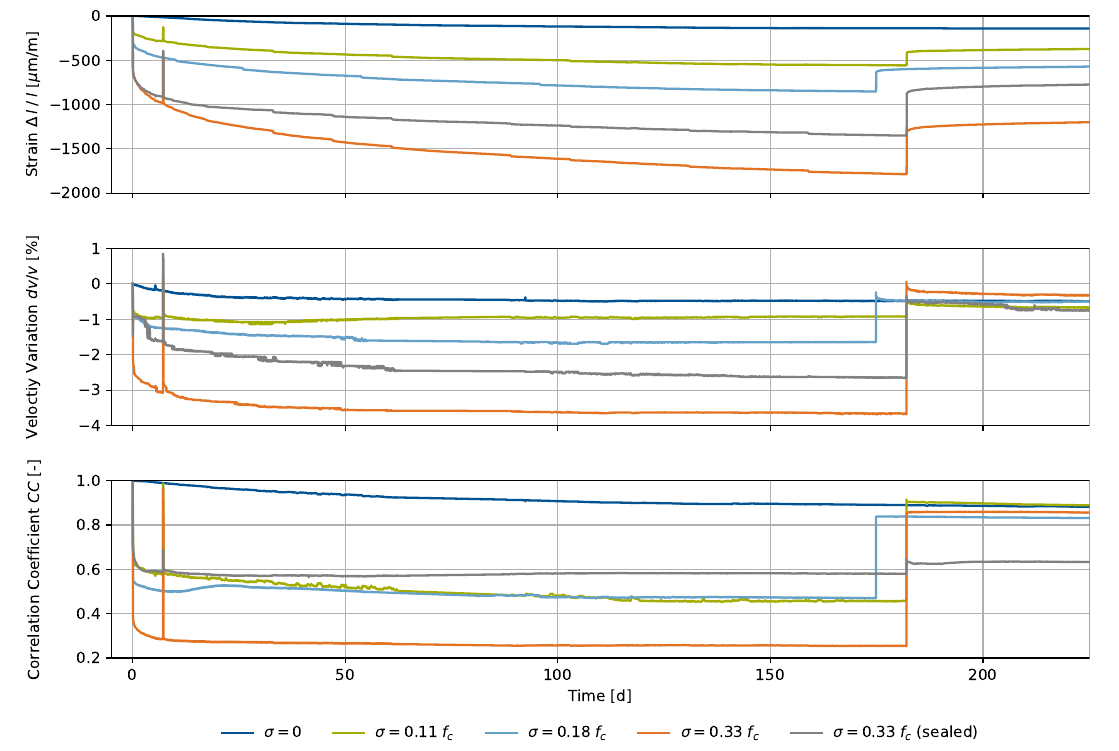
Figure 11. Shrinkage and creep experiment with different constant stresses referring to the setup in Figure 6: strains ∆ l / l , velocity variations dv / v and signal correlation coefficient CC over